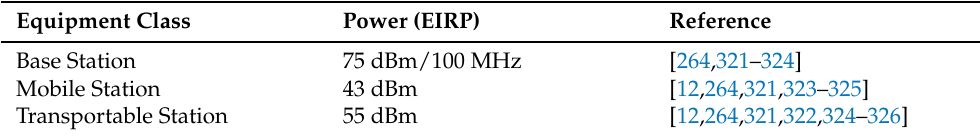
Table 10. FCC power limits for 28 GHz and 39 GHz